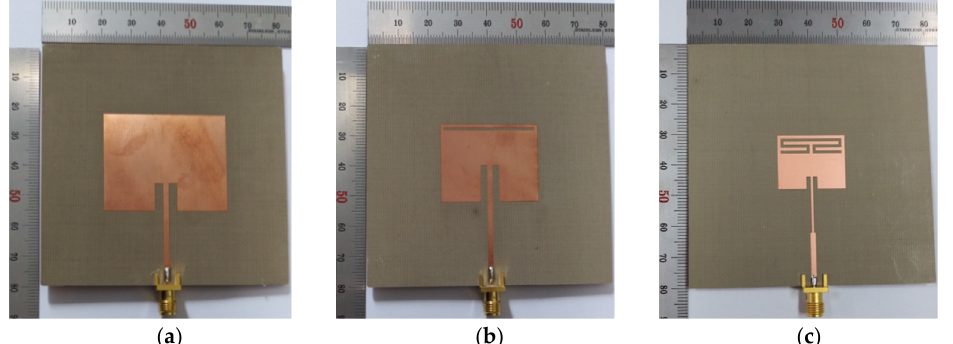
Figure 7. Photographs of the fabricated MPSAs: ( a ) conventional MPSA; ( b ) RS-loaded MPSA; and ( c ) proposed MLS-loaded MPSA.